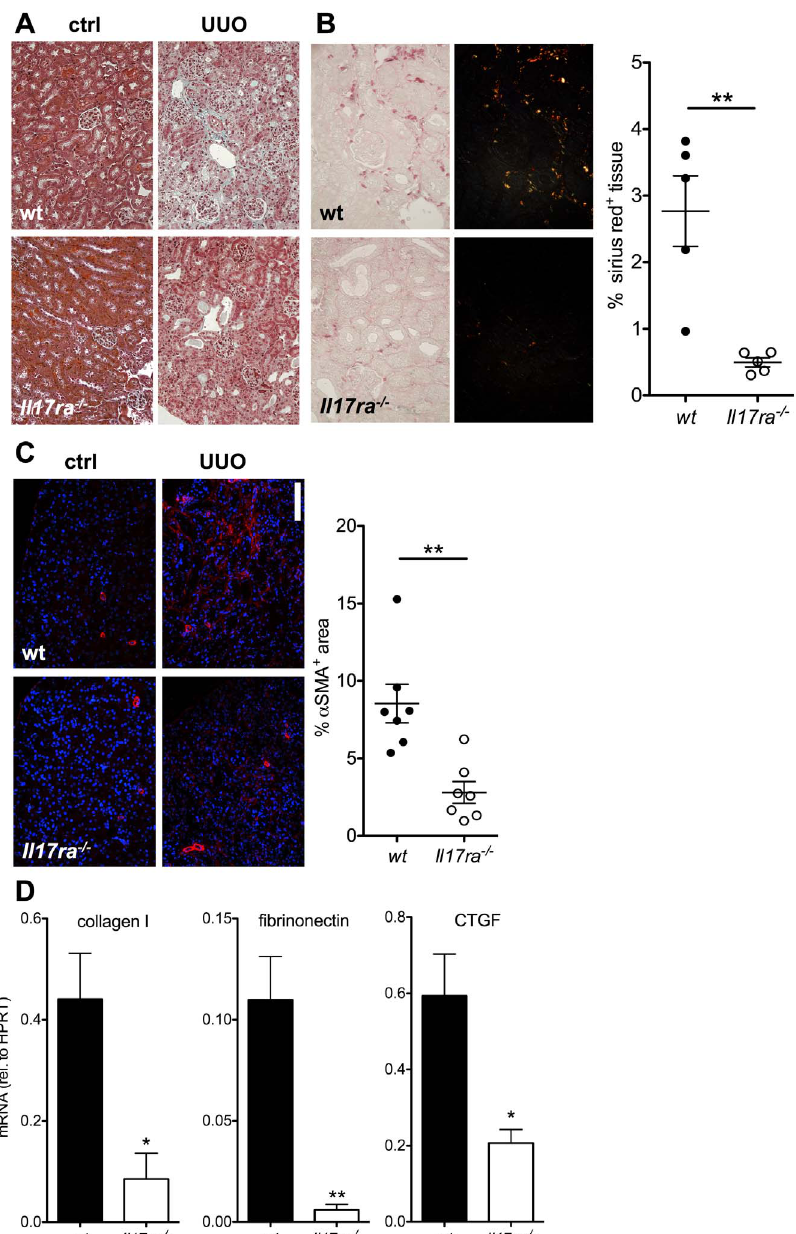
Figure 10. Decreased renal fibrosis in the absence of IL-17 receptor on myeloid cells. Unilateral ureteral obstruction was performed in wt and Il17ra -/- bone marrow chimeric mice. ( A–C ) Histologic assessment of fibrosis was conducted after Masson’s trichrome (A), Sirius red (B, birefringent sirius red positive fibrotic tissue area analyzed from n=5/group from 2 independent transplantations, 40 6 original magnification) and a SMA- immunofluorescent staining (C, n=7 from 2 independent transplantations, scale bar=100 m m) on day 7. ( D ) mRNA expression of collagen I, fibrinonectin and CTGF was assessed in obstructed kidneys by quantitative PCR (day seven, n=3, t-tests).